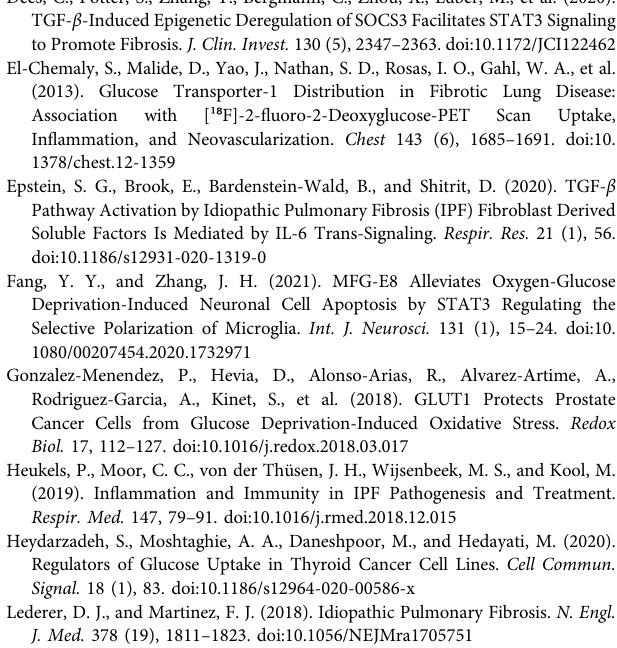
Supplementary Figure S1 | Immunohistochemistry of fi bronectin, Col1a1, and α - SMA in the lung sections from different groups ( n = 6). SupplementaryFigureS2| ToxiceffectsofDHMonmice. (A) Histologicalanalysis of the in fl ammation levels of multiorgans in different groups ( n = 6). Images were captured at 100 × magni fi cation. (B) Levels of biomarkers of the liver and kidney in different groups ( n = 6). The data are represented as the mean ± SD. Two-sided Student ’ s t-test was